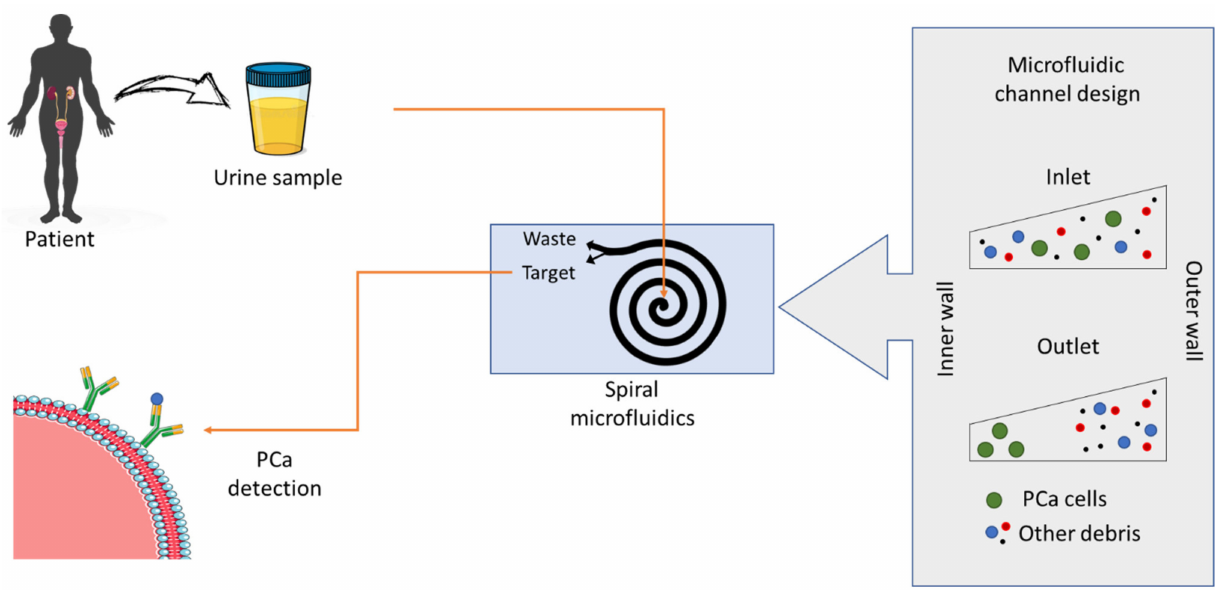
Figure 5. Schematic representation for PCa cell isolation and detection from urine samples resorting to a spiral microfluidic chip. Adapted from https://www.mdpi.com/2072--6694/12/1/81/htm 29 December 2019. Some design variations exist, such as applying inward flow, as opposed to the depicted outward flow. Image partially built using Servier Medical Art